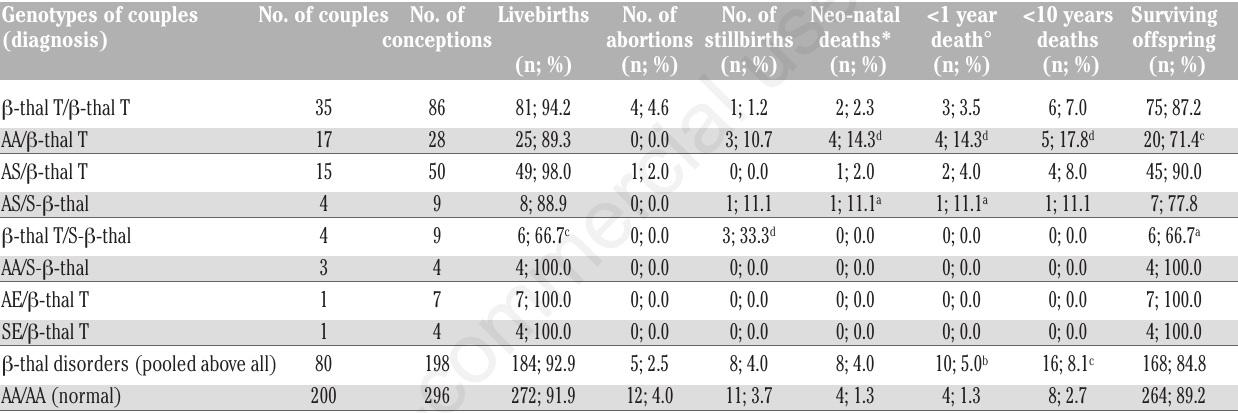
Table 1. Comparison of reproductive history of carrier couples with and without different b - thalassemia disorders. Genotypes of couples No. of couples No. of